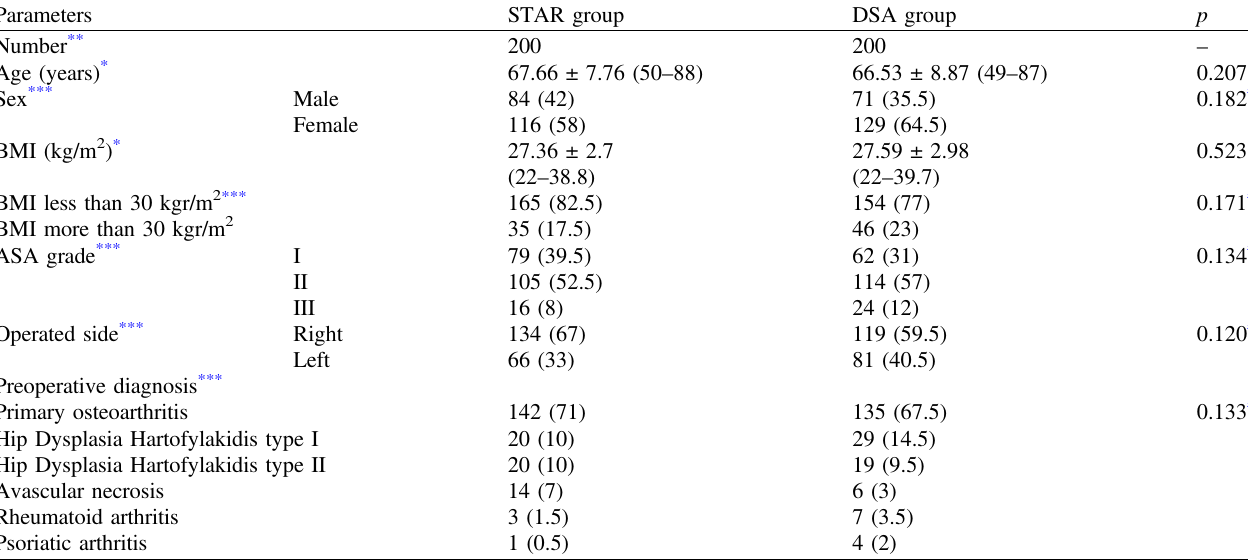
Table 1. The demographics and preoperative baseline characteristics of both groups ’ patients.